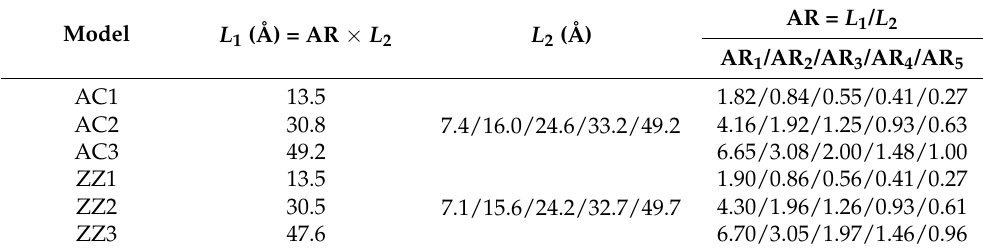
Table 1. Initial parameters of graphene ribbons with different aspect ratios (AR).